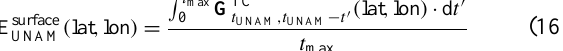
Table 2. Comparison of CO emission estimates for the Mexico City Metropolitan